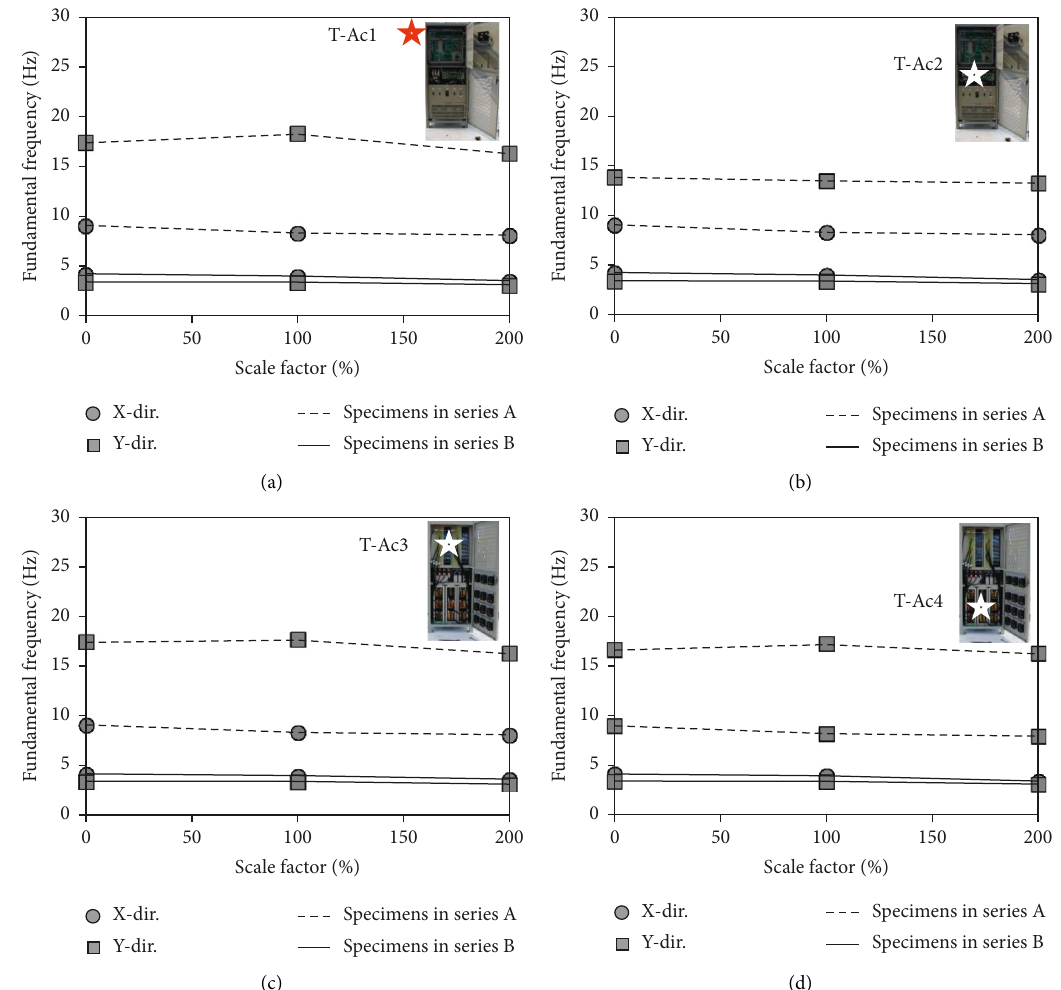
Figure 11: Fundamental frequency according to the scaling factor of the UPS specimens at different locations: (a) at the top of the UPS, (b) at the control switch, (c) at the cooling system, and (d) at the transformer. Table 4: Fundamental frequencies at different locations of the UPS test specimens.